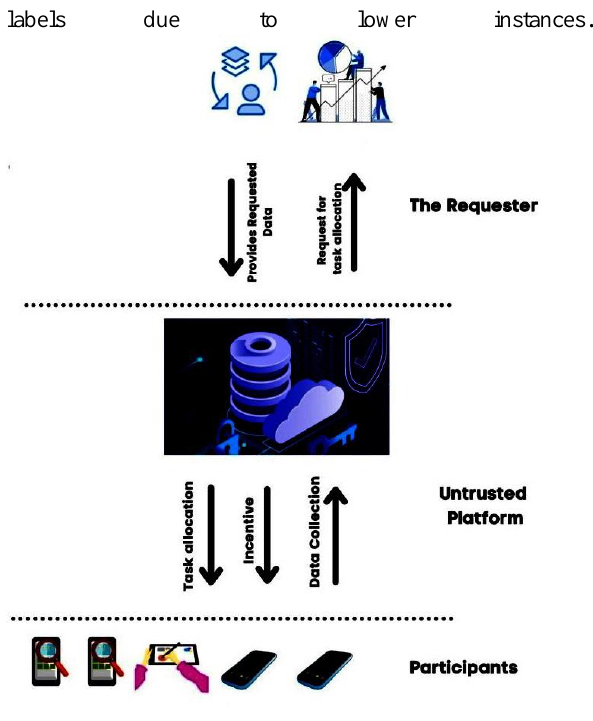
Figure 2 . Example of Untrusted